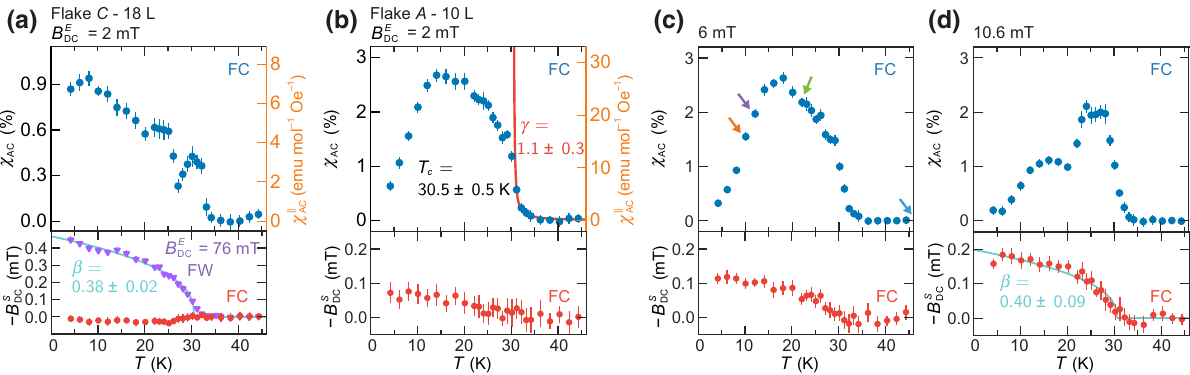
FIG. 4. Initial ac susceptibility for bulklike and ultrathin CrBr 3 . (a) χ ac (blue) for bulklike Flake C (18 layers) during field cooling = 2 mT. The dc magnetization (red), proportional to − B S (FC) at low bias field B E , remains zero during FC, indicating a finely dc dc = 76 mT follows a critical scaling fragmented domain structure. The magnetization during FW (purple) at a polarizing field B E dc (red) for Flake A (10 layers) during FC at M ( T ) ∝ ( 1 − T / T c ) β with β = 0.38 ± 0.02. (b)–(d) The susceptibility χ ac (blue) and B S dc = 2 mT, (c) 6 mT, and (d) 10.6 mT. Flake A displays a rectangular hysteresis curve more common in ultrathin CrBr (b) B E 3 . The dc = 2 mT. The susceptibility χ = 30.5 K with quantitative susceptibility, χ (cid:7) ac , is larger for Flake A than Flake C at B E ac diverges at T c dc a critical exponent γ = 1.1 ± 0.3 [red fit in (b), upper], while the dc magnetization scales with a critical exponent β = 0.40 ± 0.09 [cyan fit in (d), lower]. The arrows in (c) indicate temperatures for frequency-dependent measurements presented in Fig. 5. All χ ac data here are taken at f ac = 238 kHz with XY8- N 2 and are baseline corrected using the flake’s dc stray field B S dc